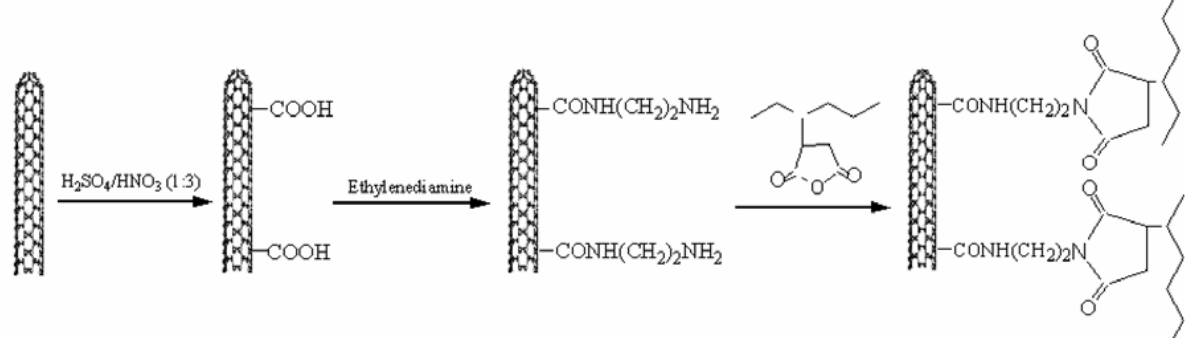
Figure 43. Grafting of PP onto MWCNTs. Reproduced with permission from ref.